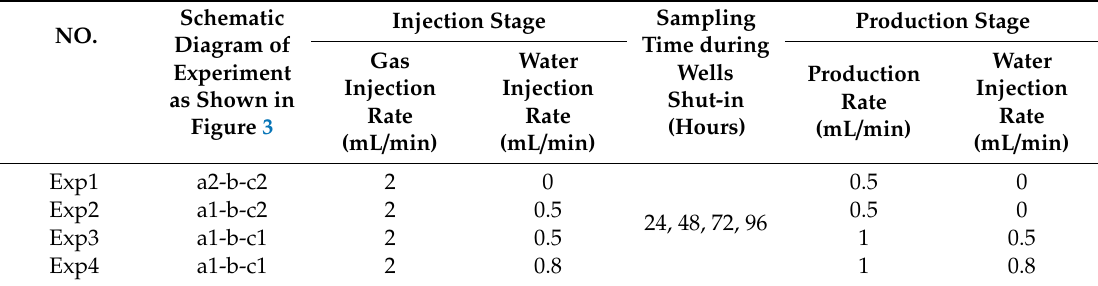
Figure 3. Schematic diagrams of the assisted gas–oil countercurrent (GOC) experiment. ( a1 ) Gas injection with water injected simultaneously; ( a2 ) gas injection without water injected; ( b ) wells shut-in; ( c1 ) production with water injected simultaneously; ( c2 ) production without water injected. Table 3. The parameter of different gas–oil countercurrent experiments.